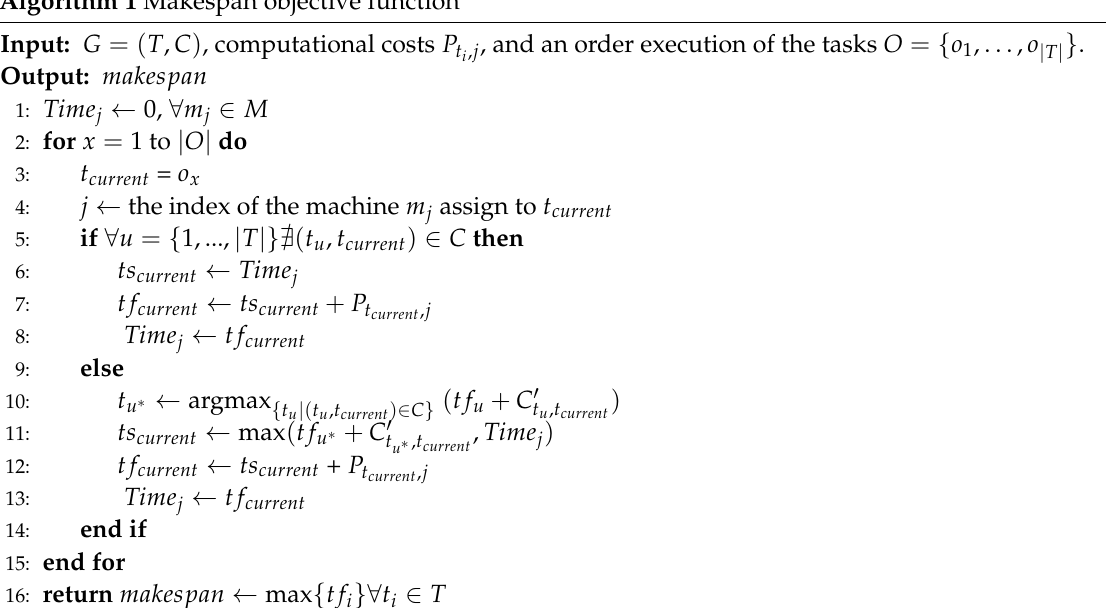
Table 2. Tasks’ order of execution.